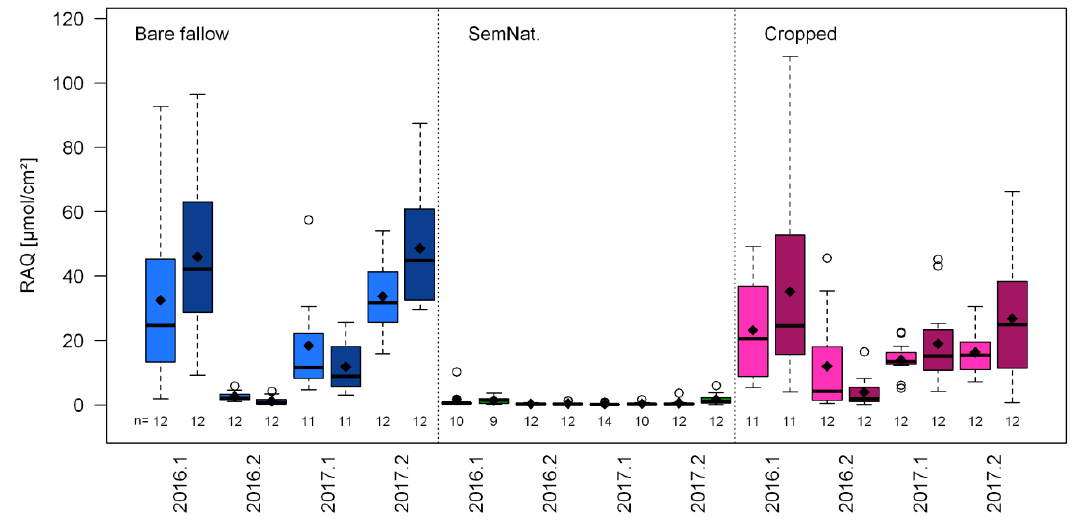
Figure 8. Seasonal cumulative bio-available nitrate displayed as resin adsorption quantities (RAQ) [ µ mol/cm 2 ] in the upper (light colors) and lower topsoil (dark colors) at each land-use type (different colors). Values are given for the four rainy seasons in 2016 and 2017.